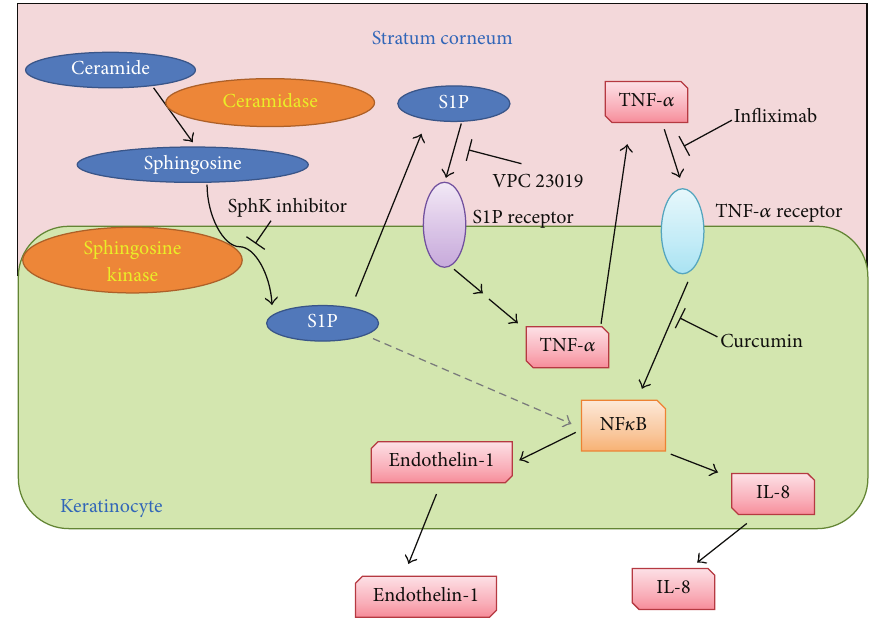
Figure 3: Schematic mechanism of the production of inflammatory mediators by ceramide metabolites in human keratinocytes. PaCDase degrades ceramide into sphingosine in the stratum corneum, and sphingosine is converted to S1P by SphK of keratinocytes. S1P is then released extracellularly and binds to S1P receptors, resulting in the production and release of TNF- 𝛼 . The released TNF- 𝛼 binds to TNF- 𝛼 receptors, activating NF- 𝜅 B and inducing the production of IL-8 and